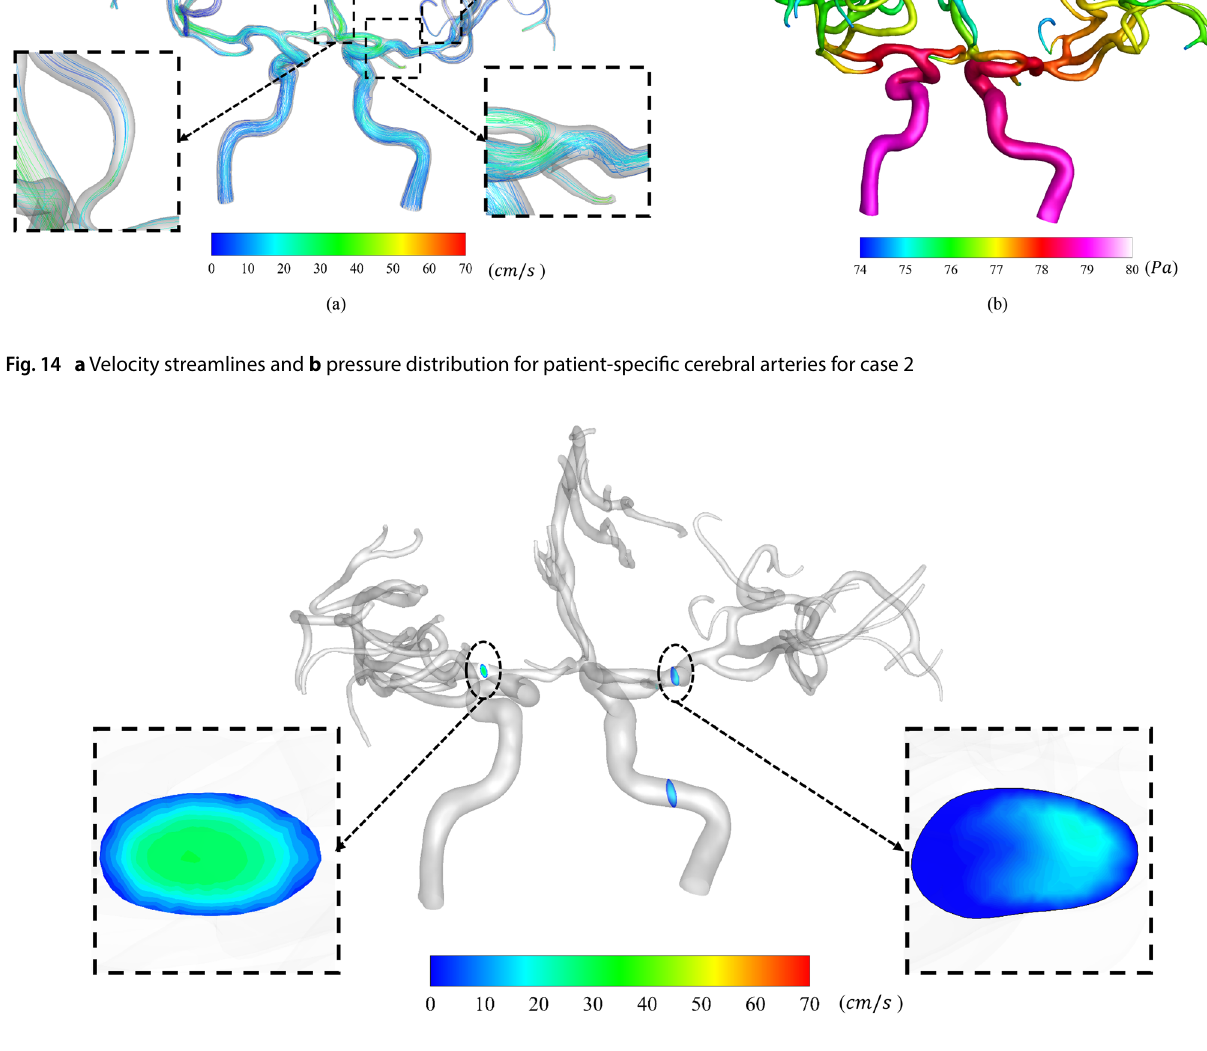
Fig. 15 The cross-section views of velocity distribution for case